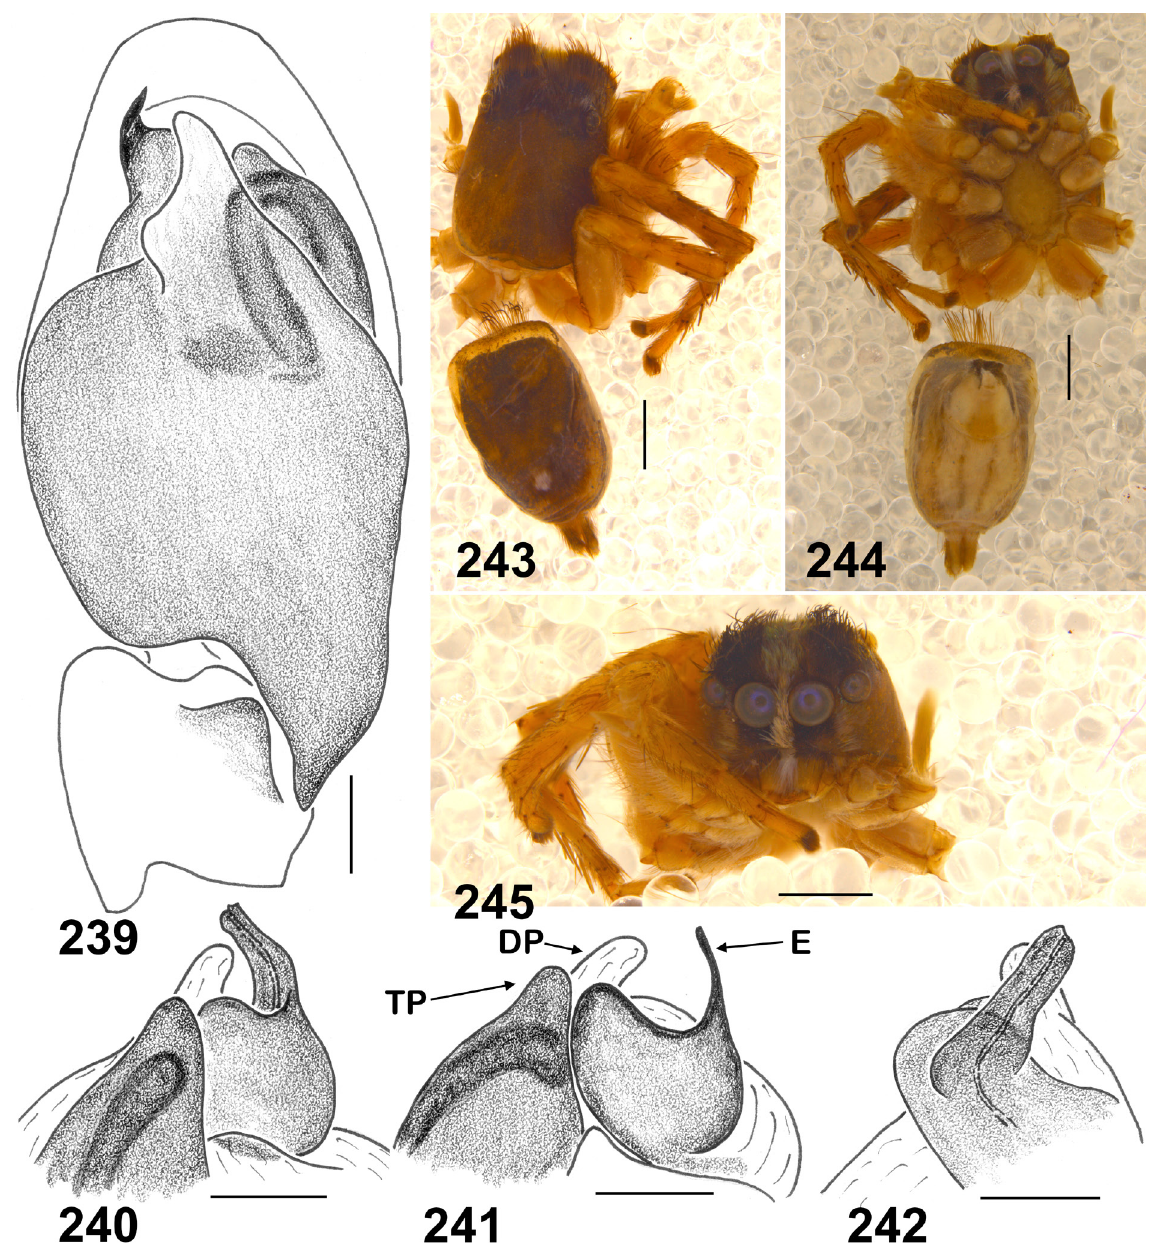
Figs 239–245. Stenaelurillus hirsutus Lessert, 1927, holotype. 239 . Male palp, ventral view. 240 . Embolic division, retrolateral view. 241 . Embolic division, dorsal view. 242 . Embolic division, median view. 243–245 . General appearance. Abbreviations: see Material and methods. Scale bars: 239–242 = 0.1 mm; 243–245 = 1